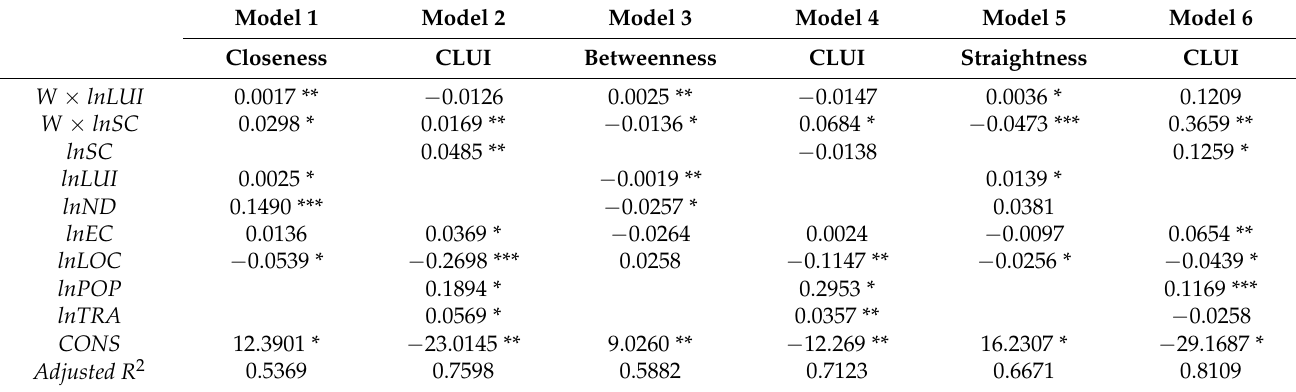
Table 2. Regression results of SC and